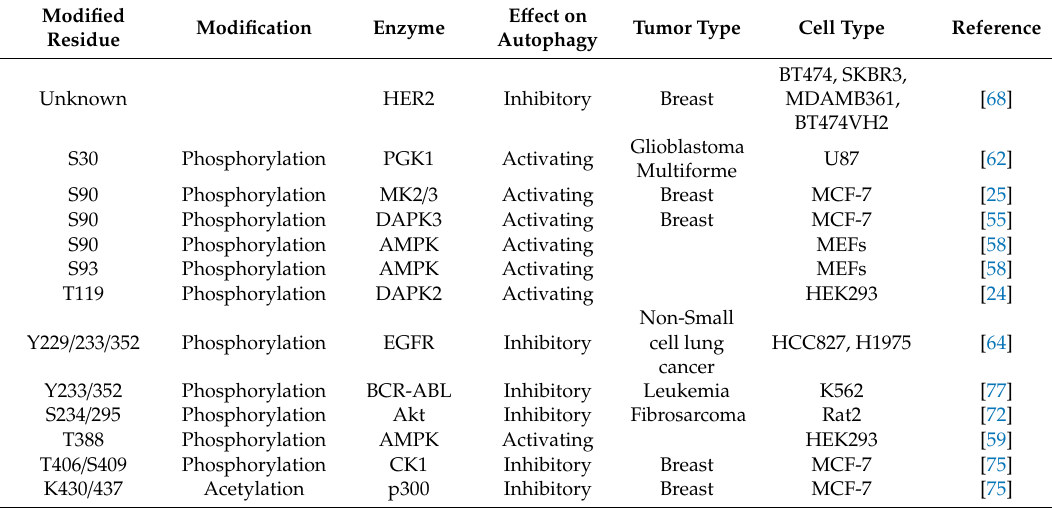
Table 1. Beclin 1 modifications implicated in